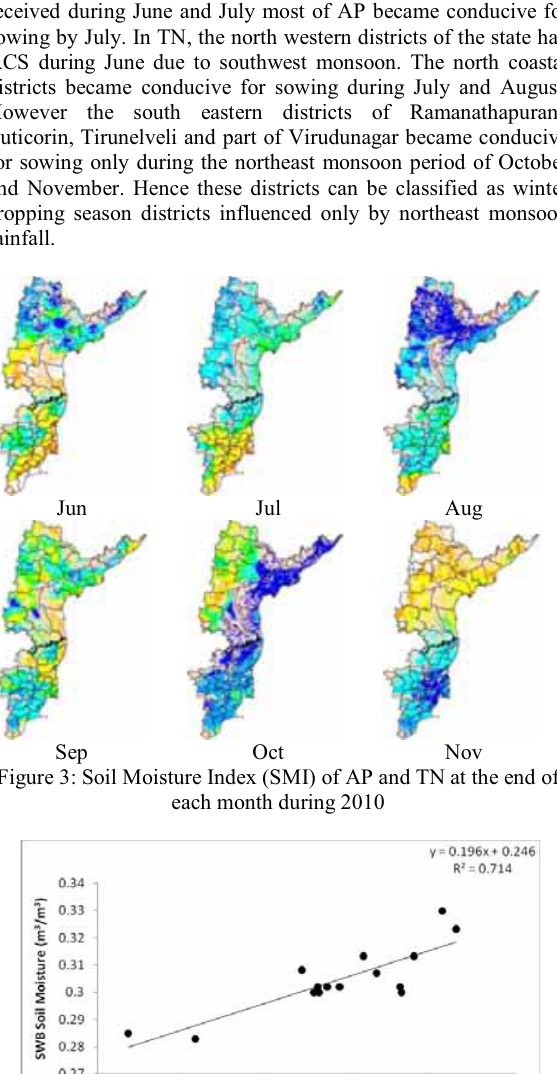
Figure 6: ACS (%) and RoI of LSWI for few typical districts